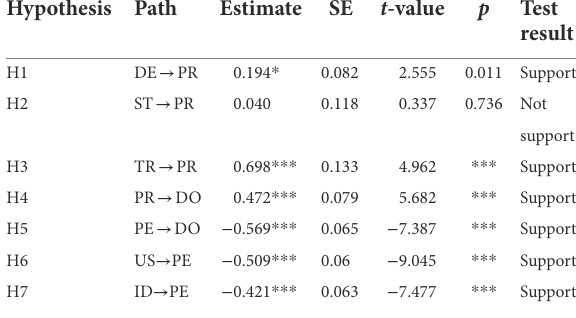
TABLE 4 Test results of the standardized path